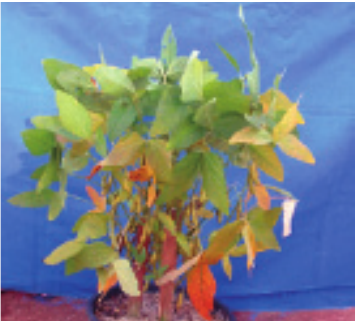
(seta).Figura 2. Planta de soja deficiente em P, com folhas amareladas e tons arroxeados nos pecíolos e